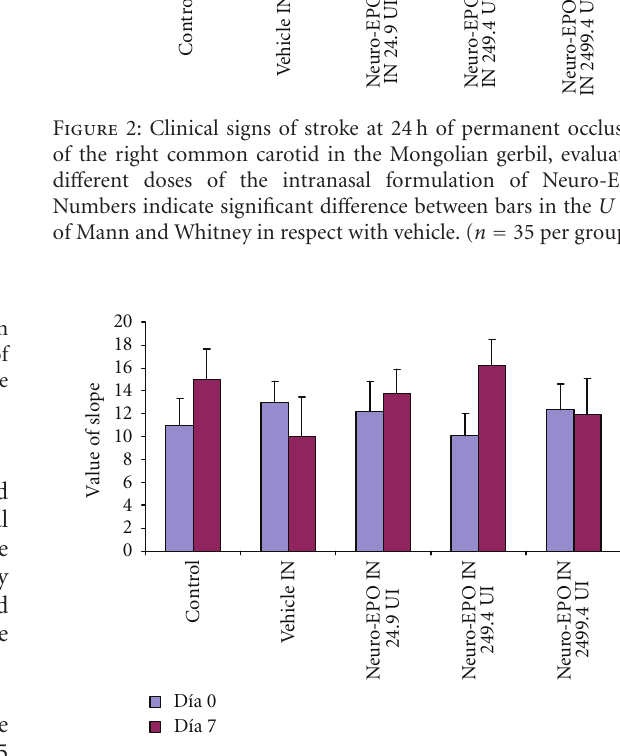
Figure 3: Values of slopes of the curve of room in the open field test, the day before and 7 days after surgery using di ff erent dosages of Neuro-EPO IN. Bars represented means ± standard deviation. P values in the Wilcoxon test. The comparison was carried out in each group among the day 0 and 7 days later. ( n = 35 per